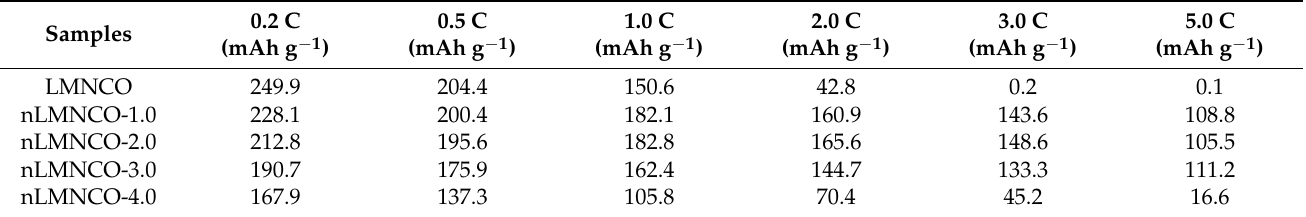
Figure 12. Rate performance of cathode materials. Table 3. Summary of discharge capacities at each rate of current density of the cathode materials.